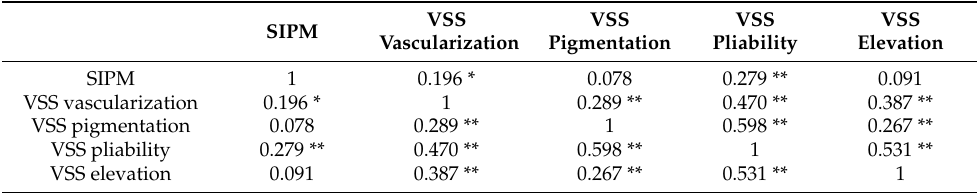
Table 7. The inter-correlation matrix of MPIS with VSS.